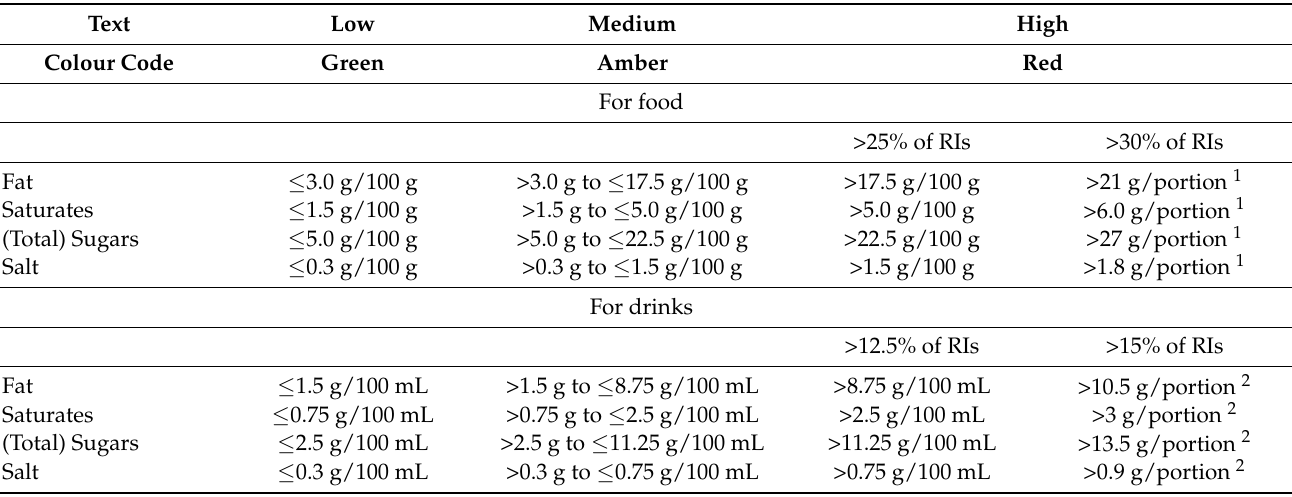
Table 1. Criteria for 100 g of food (whether or not it is sold by volume) and for drinks (per 100 mL) adapted from